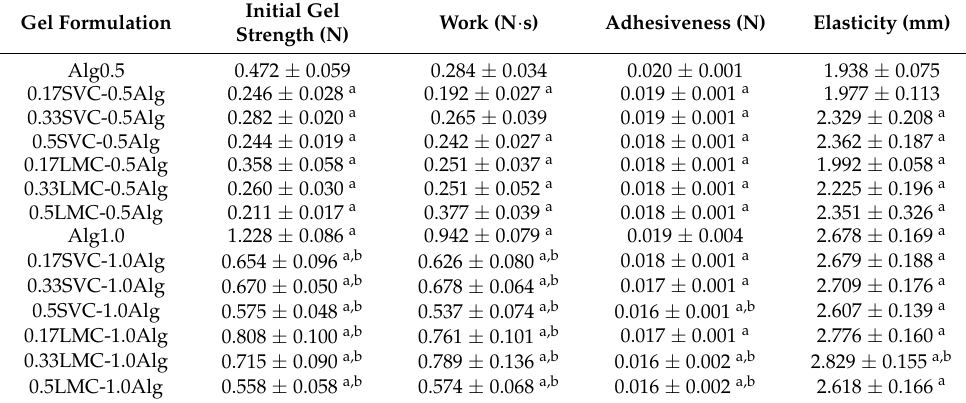
Table 2. Texture properties of